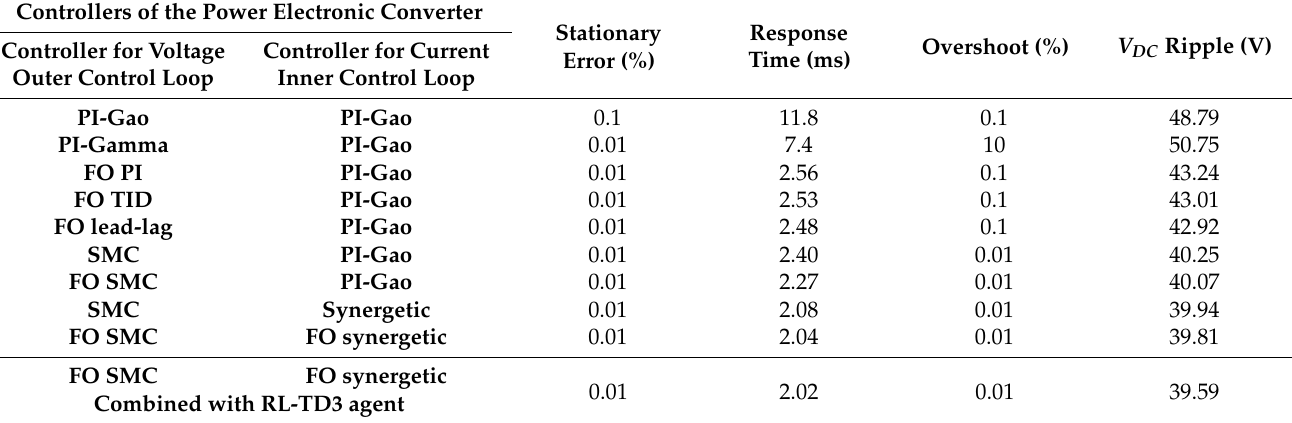
Table 2. Performance indices for the power electronic converter control systems based on the proposed